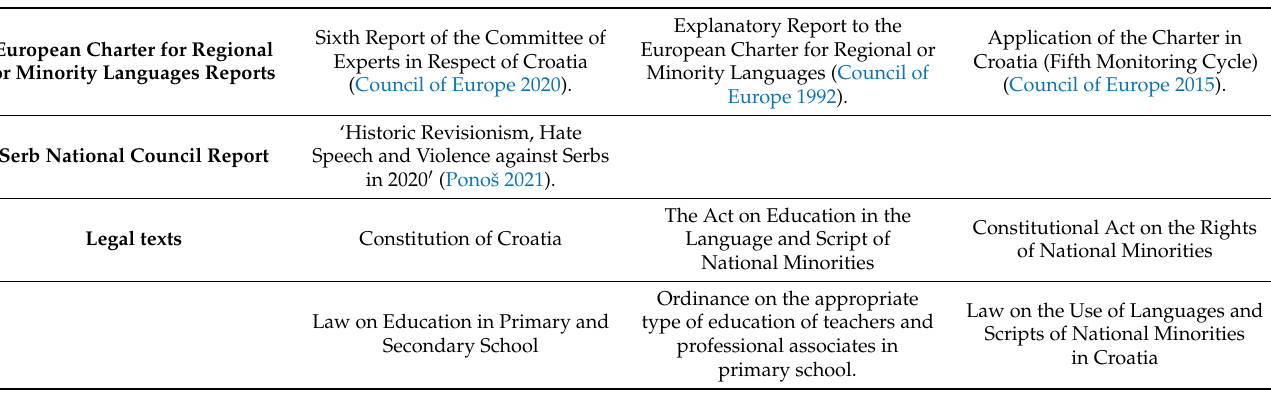
Table A2. A description of the documents under